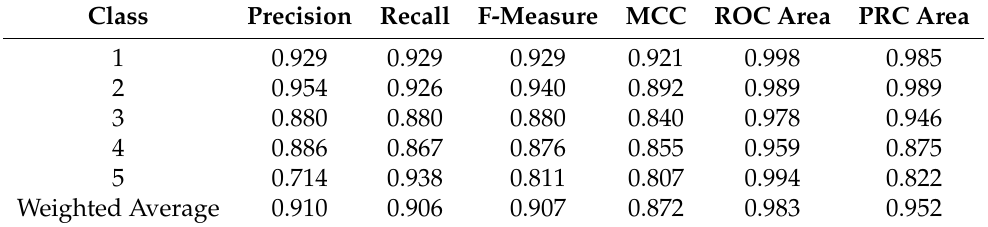
Table 8. AIDE accuracy details.